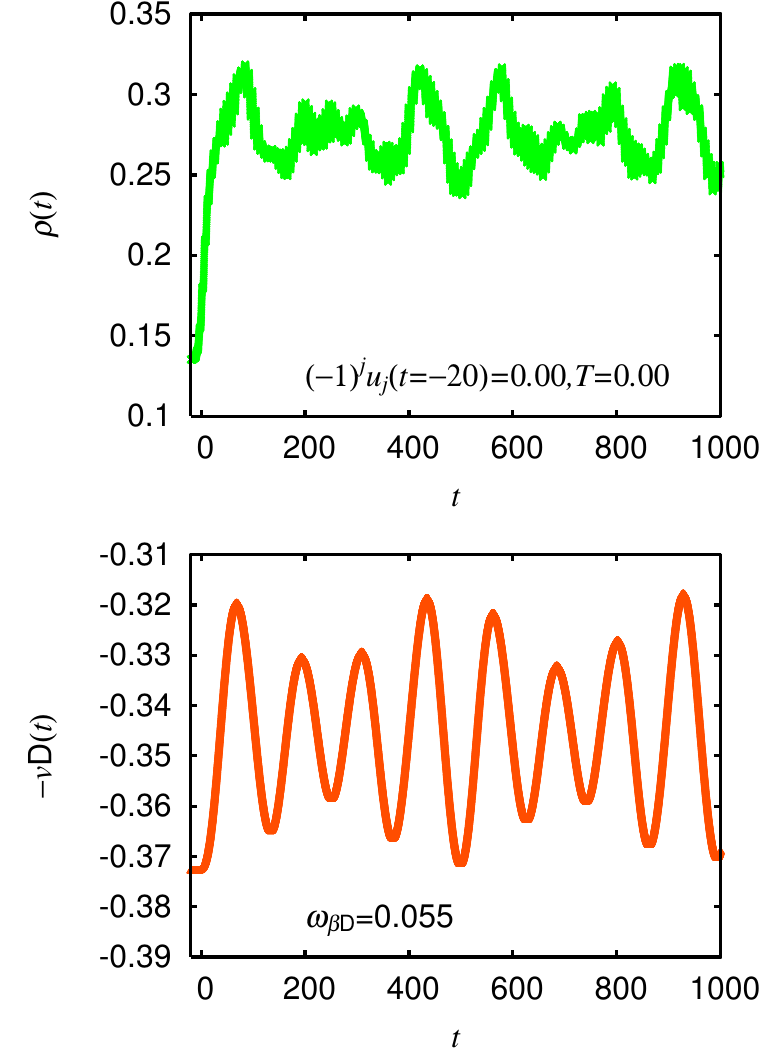
Figure 3. Transient ionicity ρ ( t ) (upper) and displacement − v ω = 0.055 (lower) during and after charge-transfer photoexcitation of neutral phase using β D ω = 0.65, T = 10, and F = 1.4 in case of strong Peierls and Holstein couplings pmp pmp λ = 0.167 and λ = 0.20 From [28]. Reproduced with permission from α β